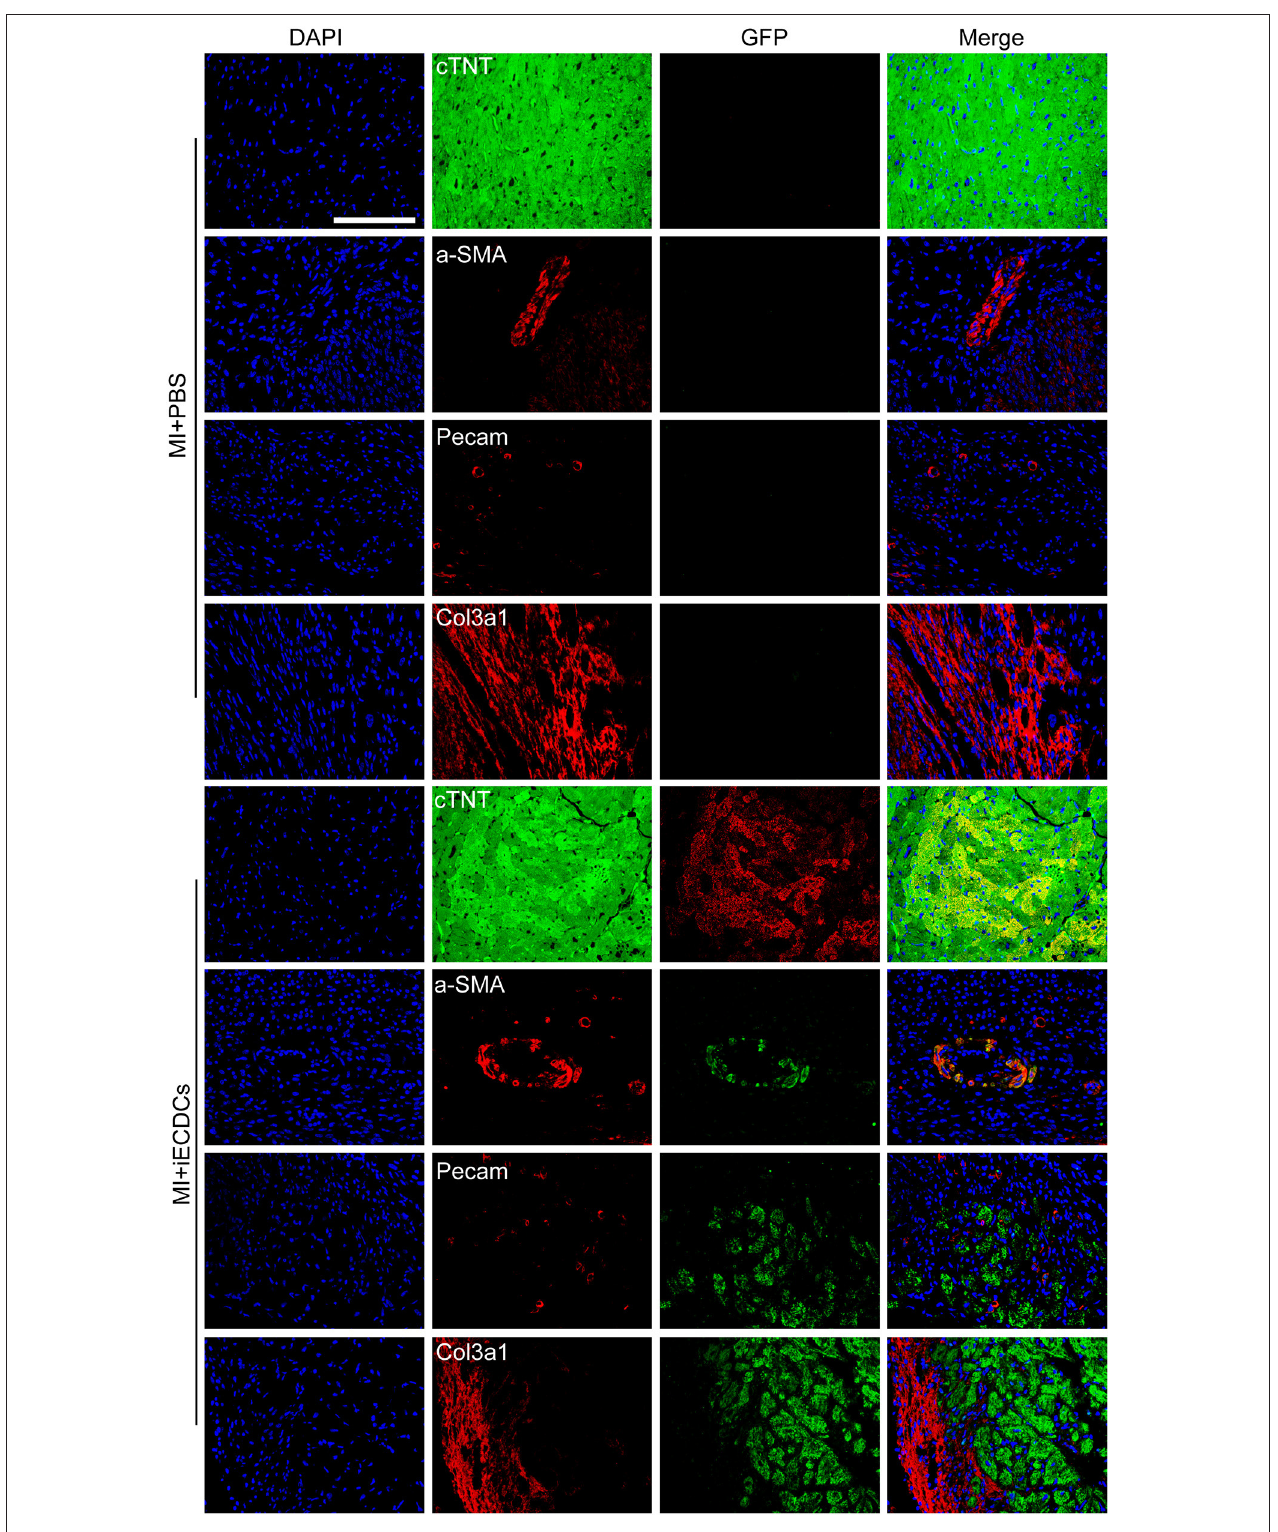
FIGURE 6 | iECDCs differentiated into cardiomyocytes and smooth muscle cells in the mouse model. GFP + iECDCs-transplanted hearts were harvested and sectioned 6 weeks post-MI. Representative images of GFP costained with cTNT, a-SMA, PECAM, and Col3a1, which indicated cardiomyocyte, smooth muscle cell, endothelial cell, and fibroblast, respectively (scale bar = 100 µ